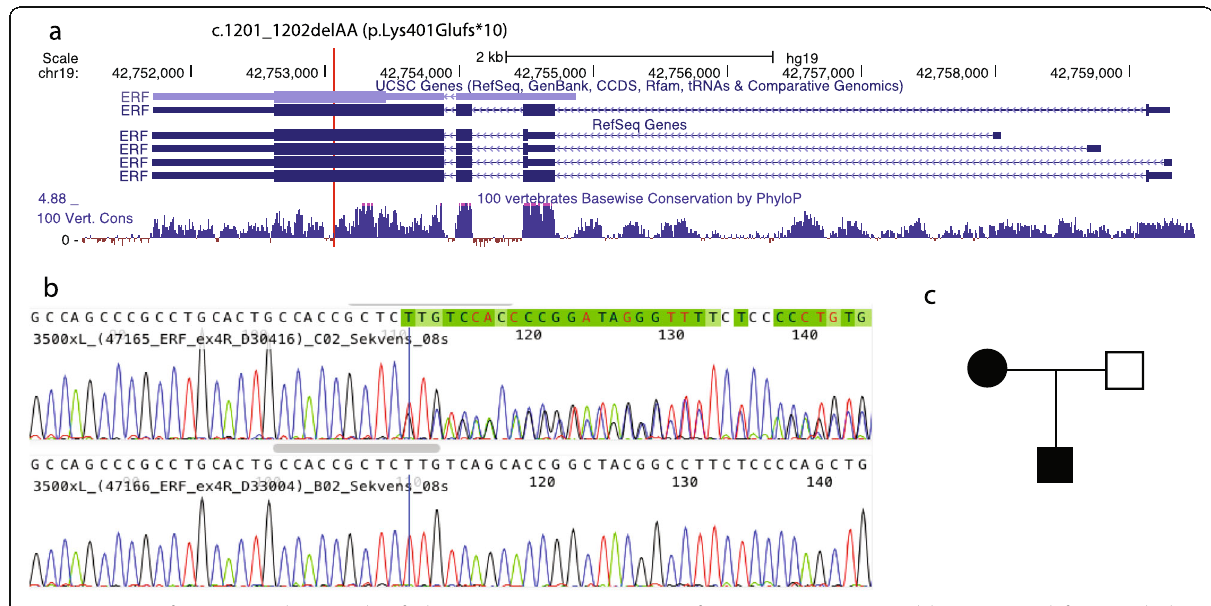
Fig. 2 Structure of ERF gene and variant identified. ( a ) Main ERF transcript consist of 4 exons, ERF c.1201_1202delAA (p.Lys401Glufs*10) marked with red line. ( b ) Confirmation of truncating frameshift variant illustrated with sequencing. ( c )